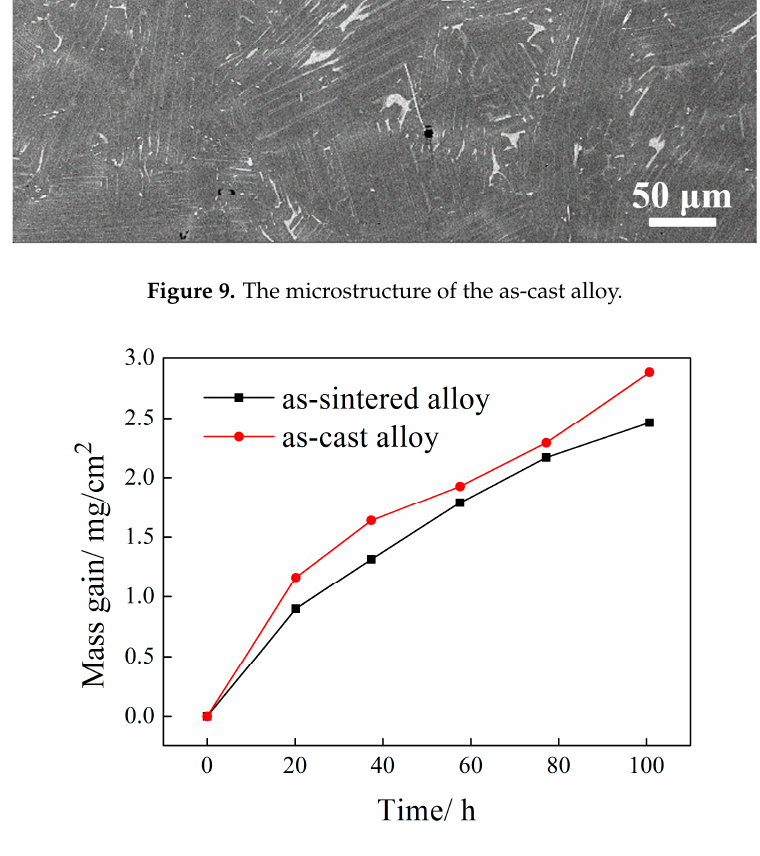
Figure 11. The X-ray diffraction patterns of both as-casted and sintered TiAl alloys after oxidation at 900 °C for 100 h.